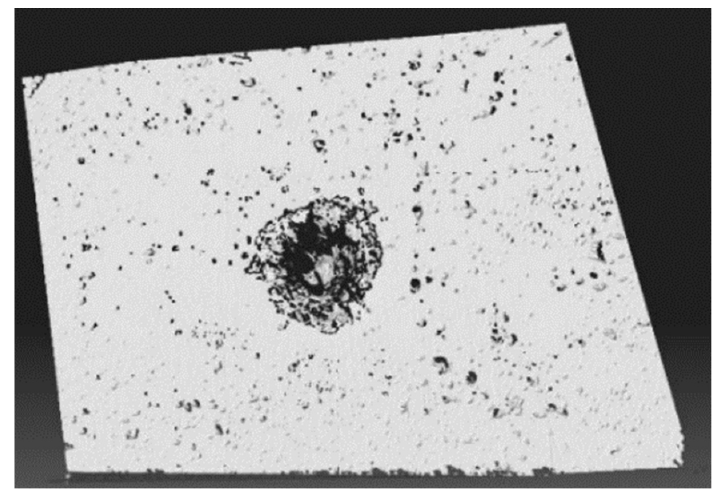
Figure 8. Three-dimensional (3D) model of the scanned data.